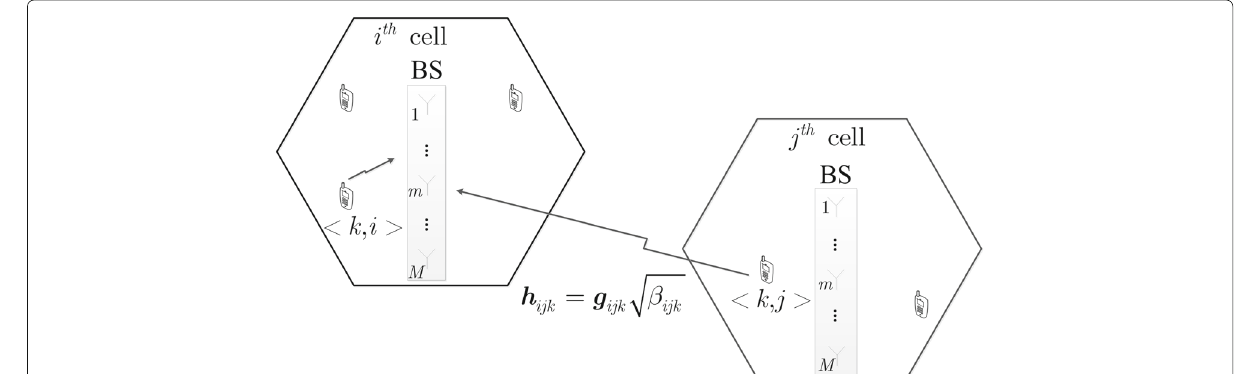
Fig. 1 The model of a massive MIMO multi-cell multi-user